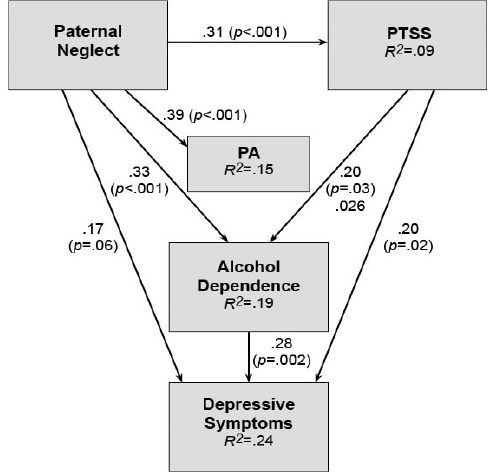
Figure 2. Physical assault ( PA ) Path Analysis Model: Effects of PA and Paternal Neglect on symptoms of posttraumatic stress, depression and alcohol dependence.